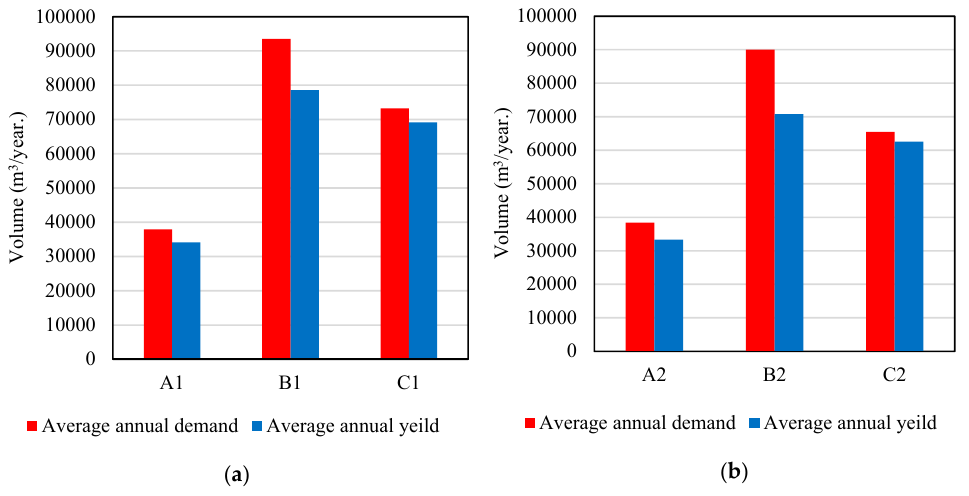
Figure 6. Comparison of annual demand to estimated stormwater yield for each SWH scenario assuming: ( a ) toilet flushing only (WDA 1); and ( b ) toilet flushing, clothes washing and lawn irrigation (WDA 2).